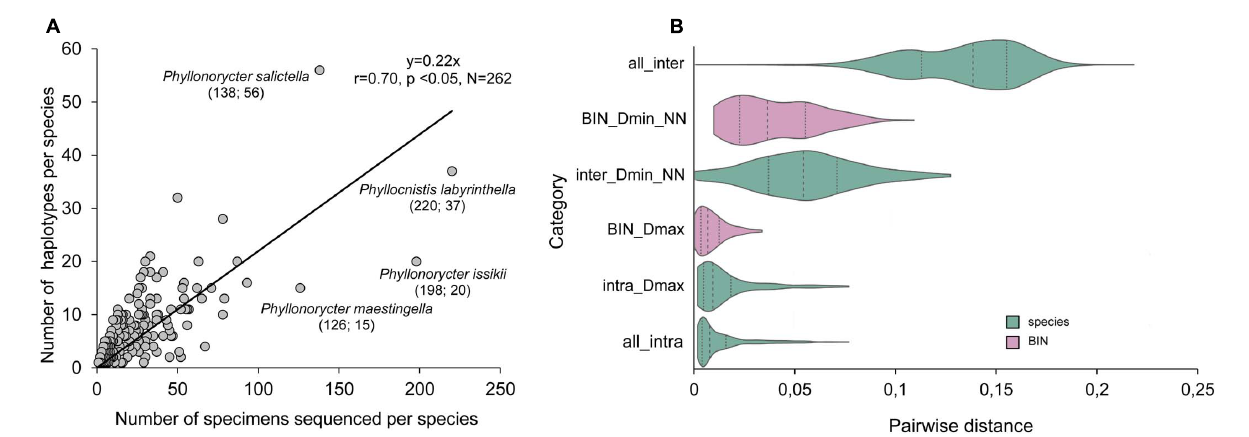
FIGURE 3 | Intra and interspecific diversity of European Gracillariidae. (A) Number of distinct haplotypes per species vs number of specimens sequenced per species. Total number of distinct haplotypes: 1,491; total number of specimens sequenced: 6,791. The correlation equation, Pearson correlation coefficient, probability (p) and sampling number are shown in the graph ( N = 262 sequences). A point represented by Cameraria ohridella (1,932 specimens; 14 haplotypes) was excluded from calculation because its sampling was biased with a large number of samples from a Malaise trap under a single highly infected horse chestnut tree. The gracillariid species with sampling > 100 specimens are indicated in the graph: species name (number of specimens; number of haplotypes). (B) Violin plot showing the pairwise distances between and within species and BINs. “all_inter” and “all_intra” show the inter- and intraspecific distances, respectively, across all species in the dataset. “Dmin_NN” shows the minimum distances to the nearest neighbor, and Dmax the maximum distances within species. The dotted lines inside each “violin” indicate the first, middle and third quartiles of the data. The maximum width (observed values) of each violin is scaled to be equal across all